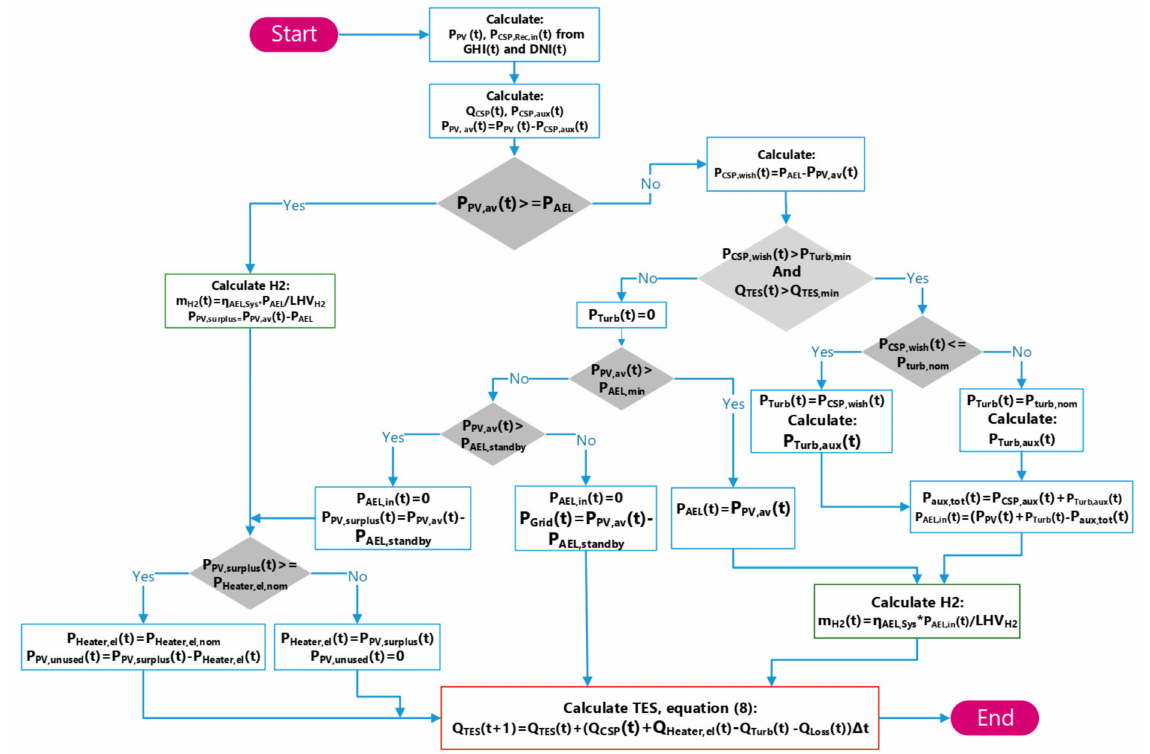
Figure 6. Operational strategy for time step calculation of PV/CSP hybrid hydrogen production plant.